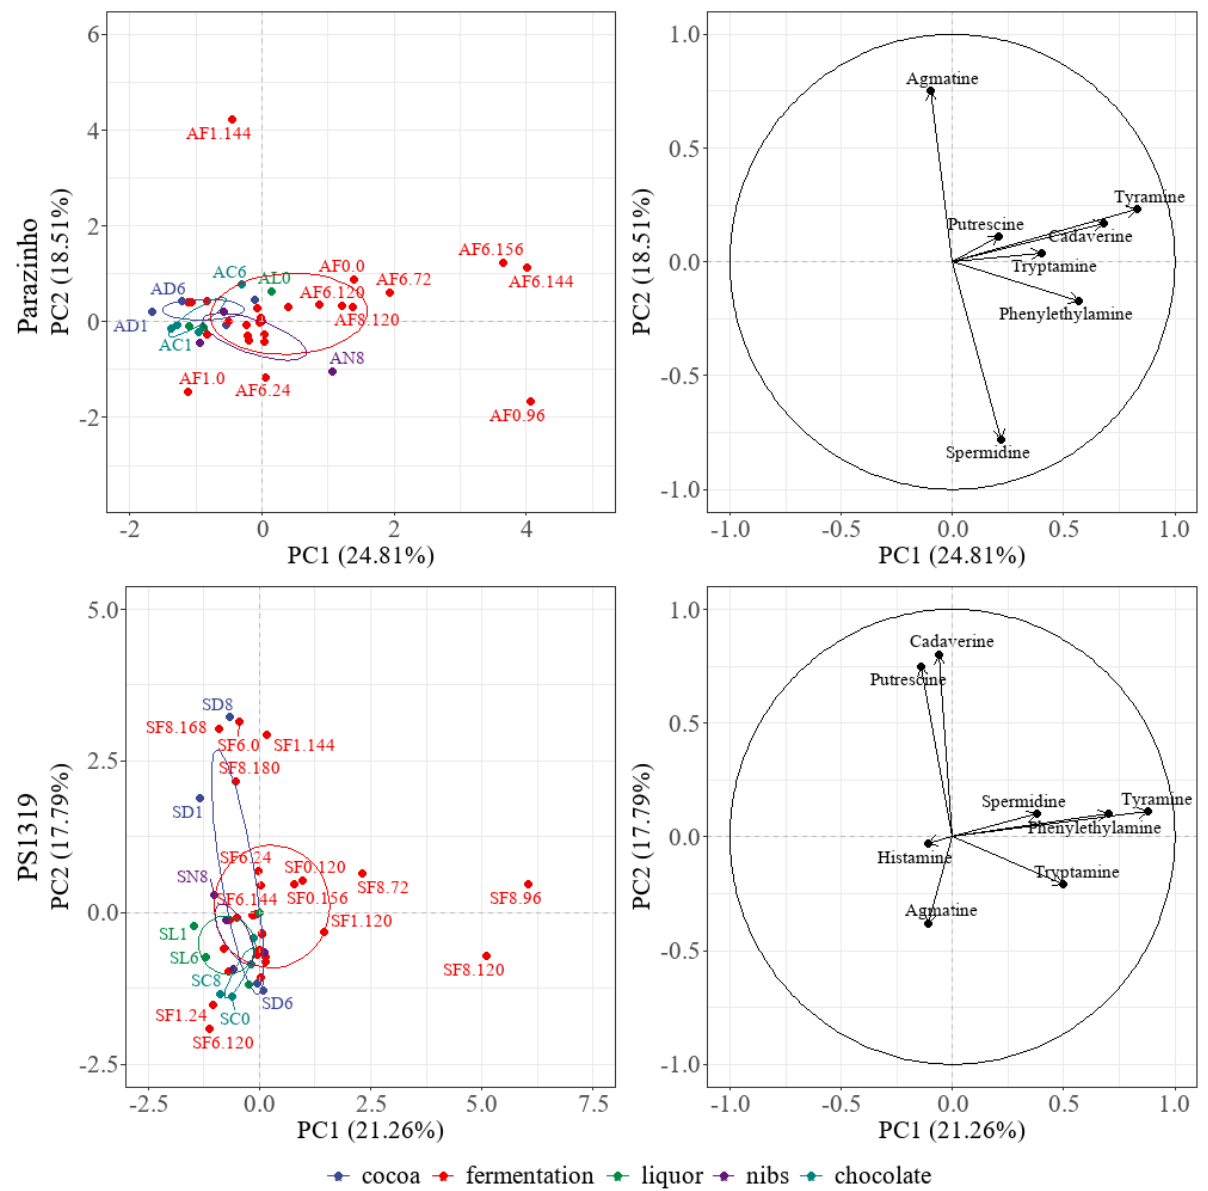
Figure 7. Principal Component Analysis of the bioactive amines during cocoa processing to compare Parazinho and PS 1319 varieties during processing steps. Note: S: PS 1319 variety. A: Parazinho variety. C: Control (freeze-dried cocoa pulp and seeds). F: fermented. D: Fermented and dried cocoa.